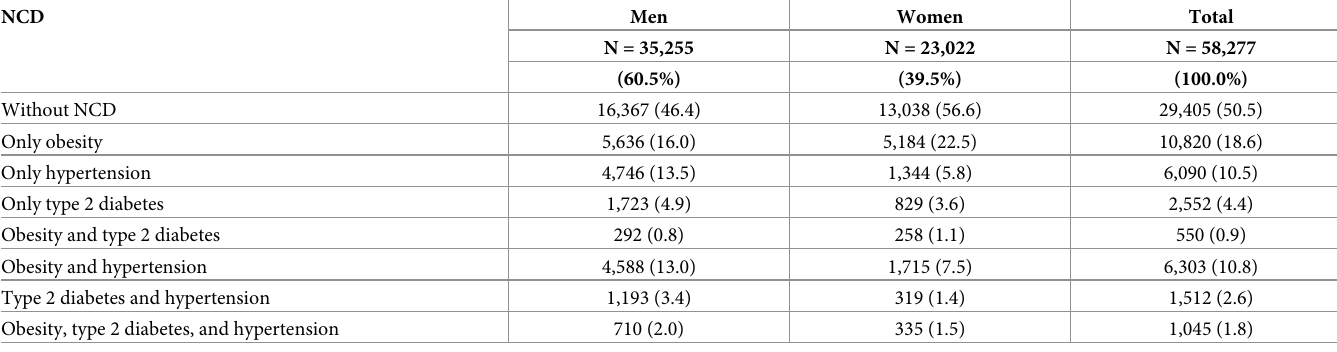
Table 2. Distribution of co-morbidities in screened